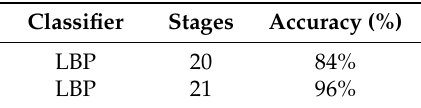
Table 1. LBP-based Adaboost Classifier Classification Results.